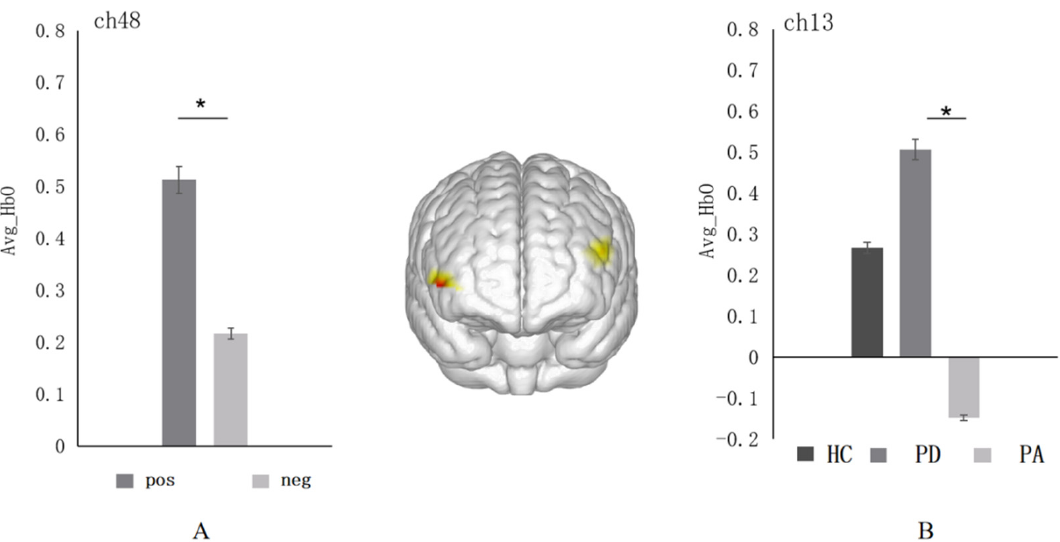
Figure 3. ( A ) Histogram of the distribution of the average oxyhemoglobin under different emotions in ch48 (right dlPFC) among three groups. ( B ) Distribution histogram of the average oxyhemoglobin in ch13 (left dlPFC) among three groups. Abbreviations: pos: positive emotion; neg: negative emotion; HC: the healthy control group; PA: the pure anxiety group; PD: the pure depression group. *: p < 0.05.